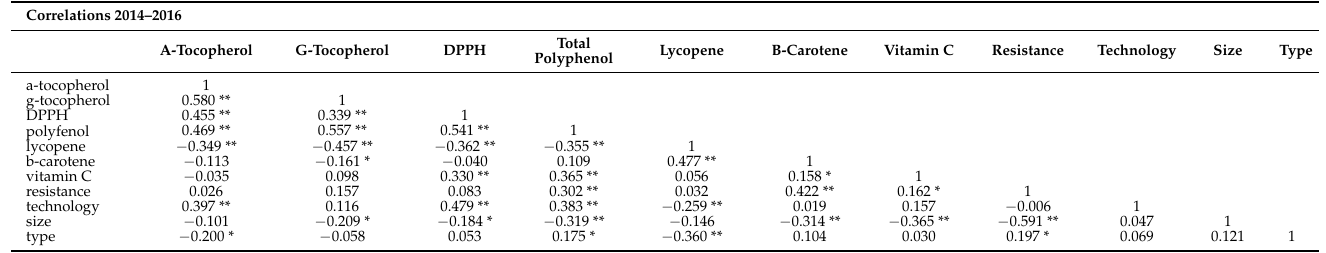
Table 4. Pearson correlation analysis among bioactive components, resistance level, fielding technol- ogy fruit size, and type of tomato. ** Correlation is significant at the 0.01 level (2-tailed). * Correlation is significant at the 0.05 level